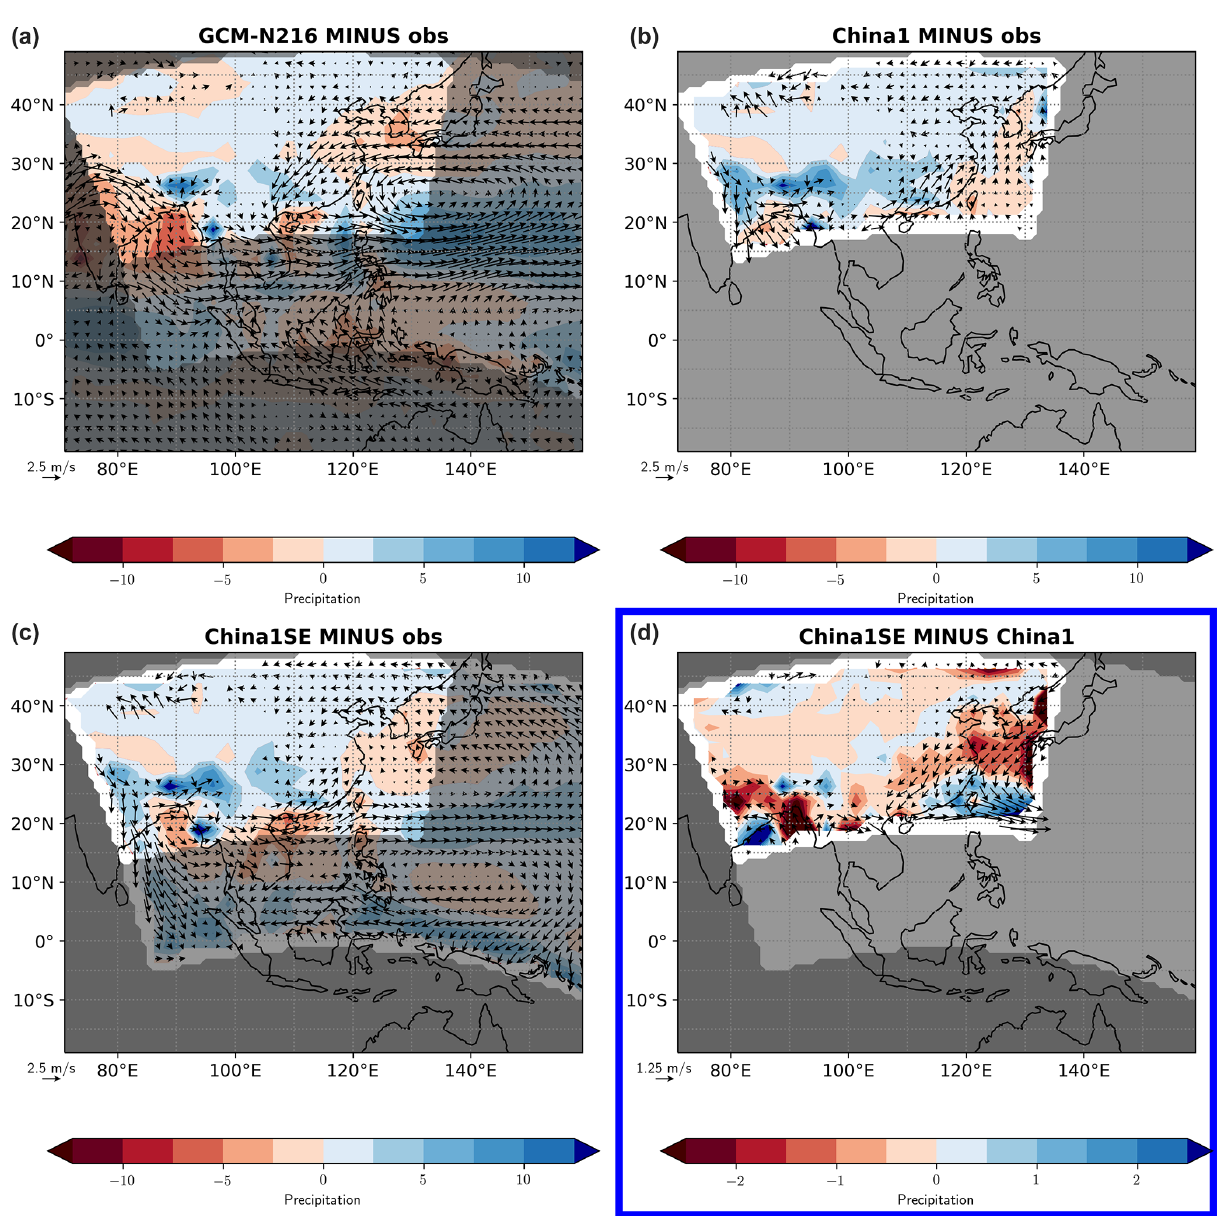
Figure 4. (a, b) JJA climatological (1989–2008) precipitation and 850hPa wind errors in the AGCM-N216 simulation and the China1 RCM simulation vs. TRMM and ERA-Interim (obs). (c, d) Effects of extending the domain towards the south and east: (a, c) China1SE minus obs; (b, d) China1SE minus China1. Colour bar indicates precipitation differences (mmd − 1 ) and vectors indicate differences in 850hPa winds. Note the difference in contour intervals and vector scale for the lower right panel. The non-shaded area highlights China1 region, the lightly shaded area highlights China1SE region, and the darker shaded area highlights areas not covered by the China1 and China1SE